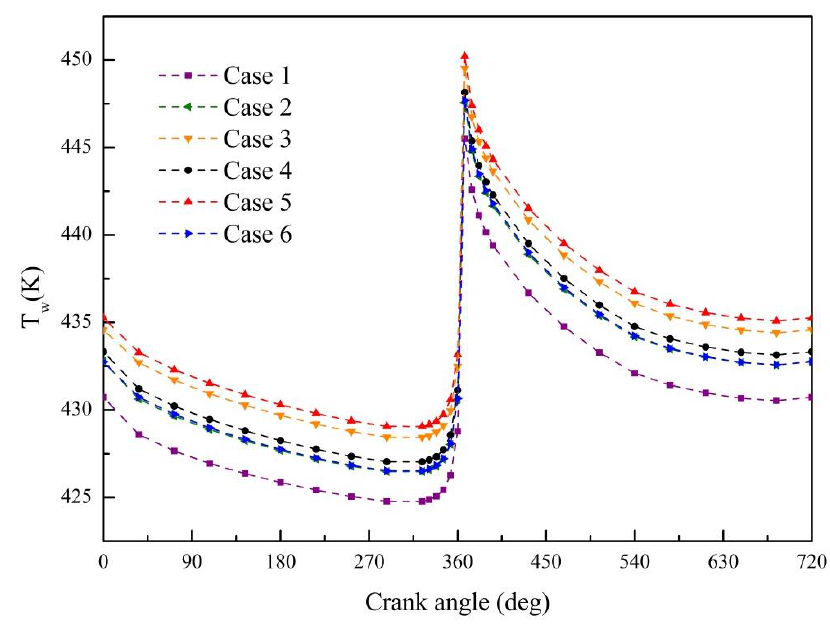
Figure 9. Average temperature of the cylinder wall.